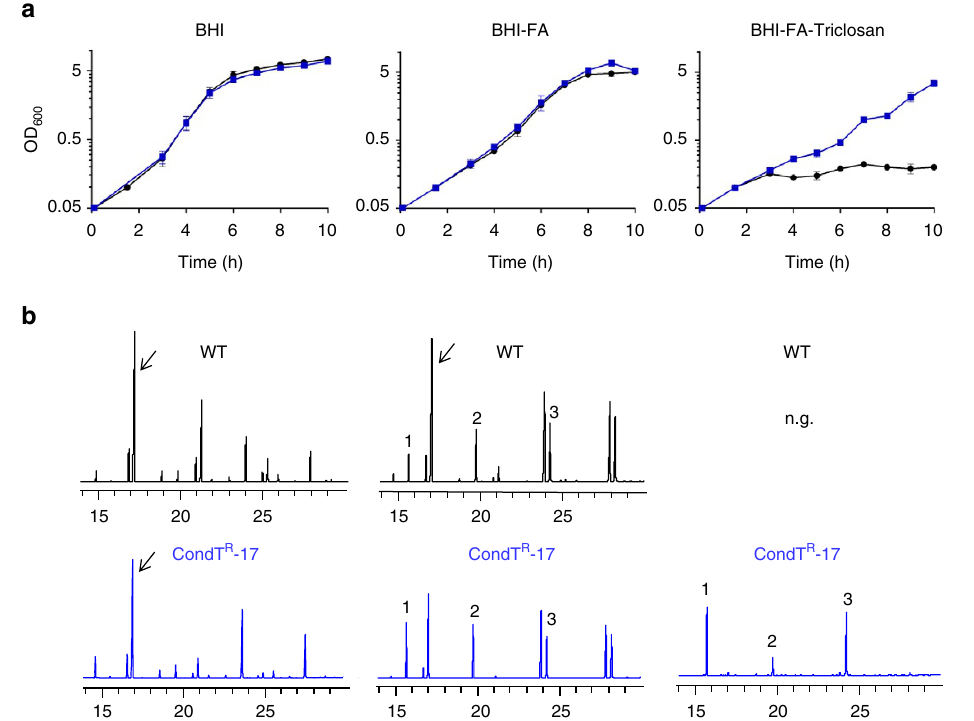
Figure 2 | Gain of function of the S. aureus CondT R -17 mutant. ( a ) Growth of WTand CondT R -17 ( fabD G196R ) S. aureus strains in BHI, BHI-FA and BHI-FA-T media. Results show the average and range of biologically independent duplicates. ( b ) Fatty acid profiles of one sample set, taken at the 10h time point. Endogenous branched-chain fatty acid ( ai 15:0) is indicated with arrows. Fatty acids are: 1- C14:0; 2- C16:0 and 3- C18:1, the fatty acids comprised in BHI-FA- T medium. N.g., no growth. Black, WT; blue, CondT R -17.